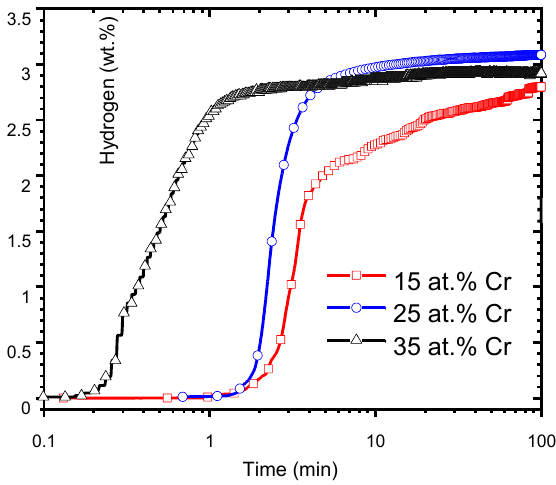
Figure 6. Kinetic curves of the first hydrogen absorption of the (TiVNb) 100 − x Cr x alloys. Experiments were performed at 24 °C and under 2000 kPa of H 2 .